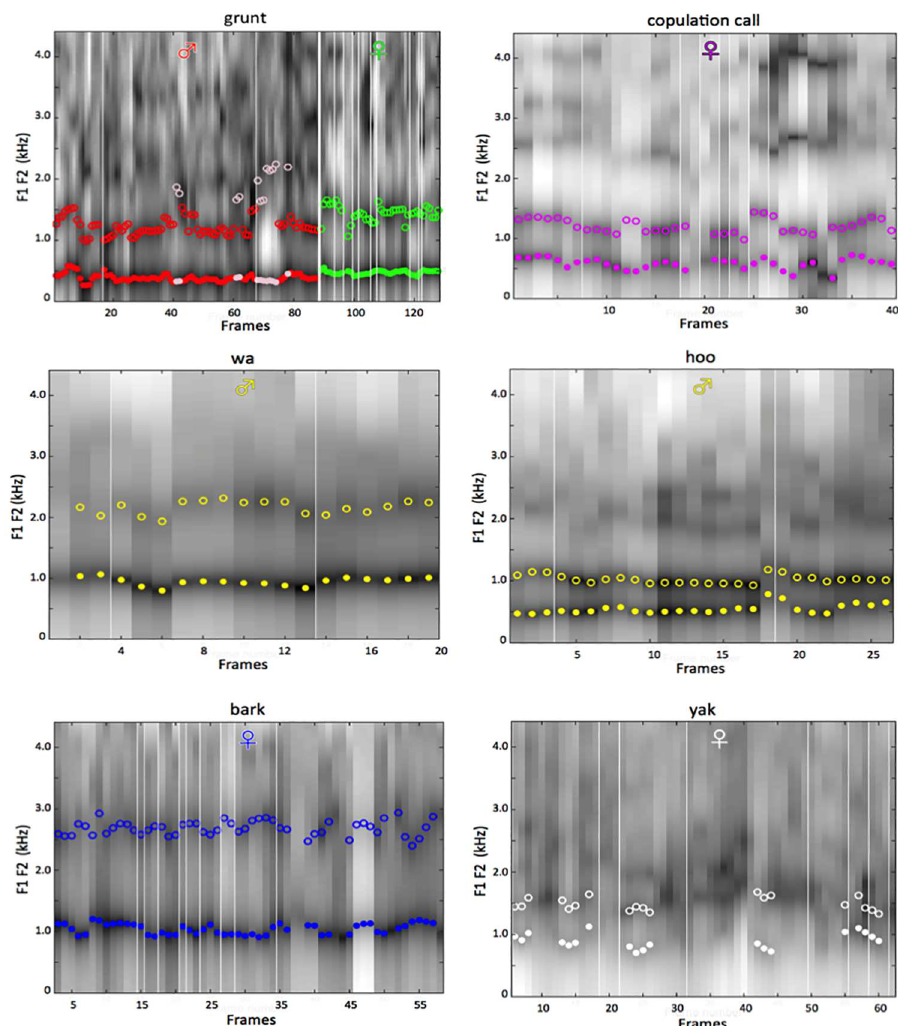
F2 were detected by LPC (within plausible ranges) and were within ± 3 standarddeviations of their class means; those frames are indicted by a dot for F1 and an open circle for F2 at their measuredfrequenciesin those frames. The acoustic results reportedwere calculatedfrom the frames thus selected. See the supplemental section for additional detailson these LPC